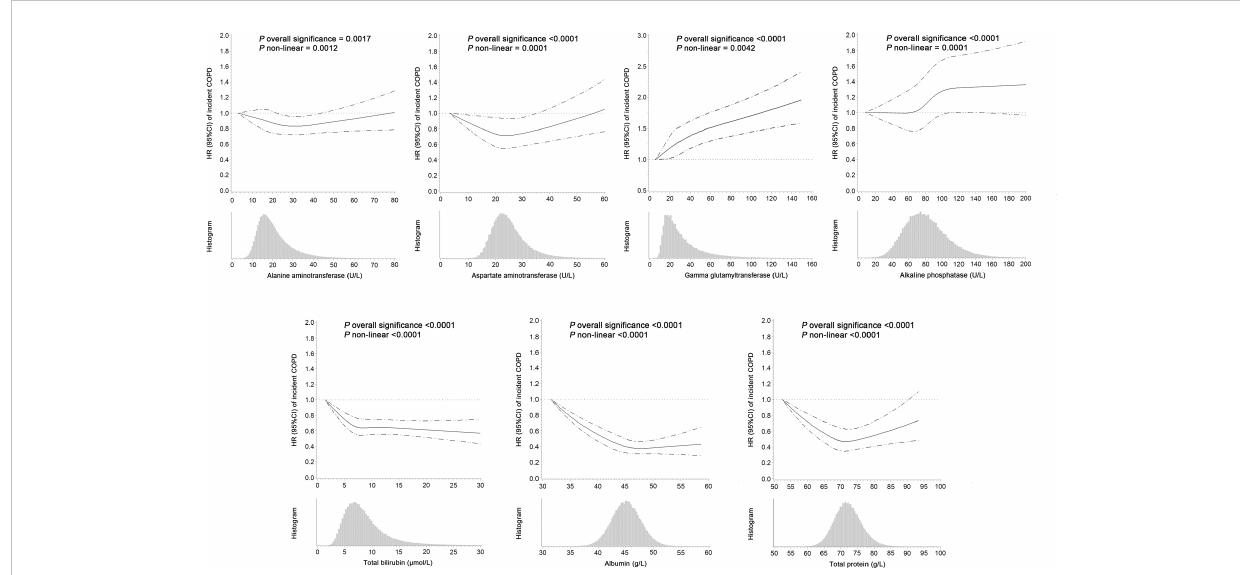
FIGURE 1 Hazard ratios (95% con fi dence intervals) of incident COPD associated with circulating levels of liver function markers and the frequency histograms of liver function markers in the UK Biobank. The associations were examined by multivariate Cox regression models based on restricted cubic splines. The solid line represents estimates of hazard ratios and dashed lines represent 95% con fi dence